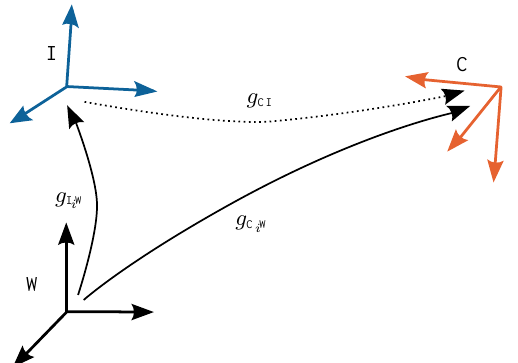
Figure 4: Both, the poses of the INS frame I and of the camera frame C can be described by rigid body motions with regard to the world frame W. The estimation of the static rigid body motion g between the devices (dotted arrow), enables by composition with the INS measurements g the description of the camera poses I i W g . C i W